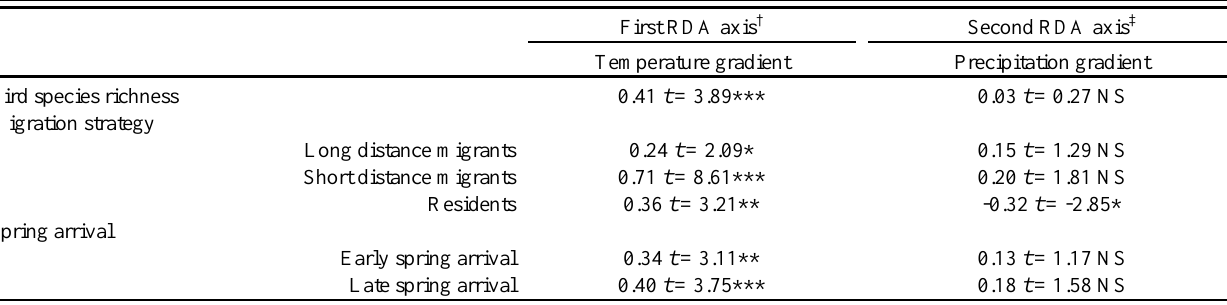
Table 3 . Partial correlation analysis (d.f. = 74) between bird species richness, migratory strategy, and spring arrival phenology and first and second axes derived from Redundancy Analysis (RDA).